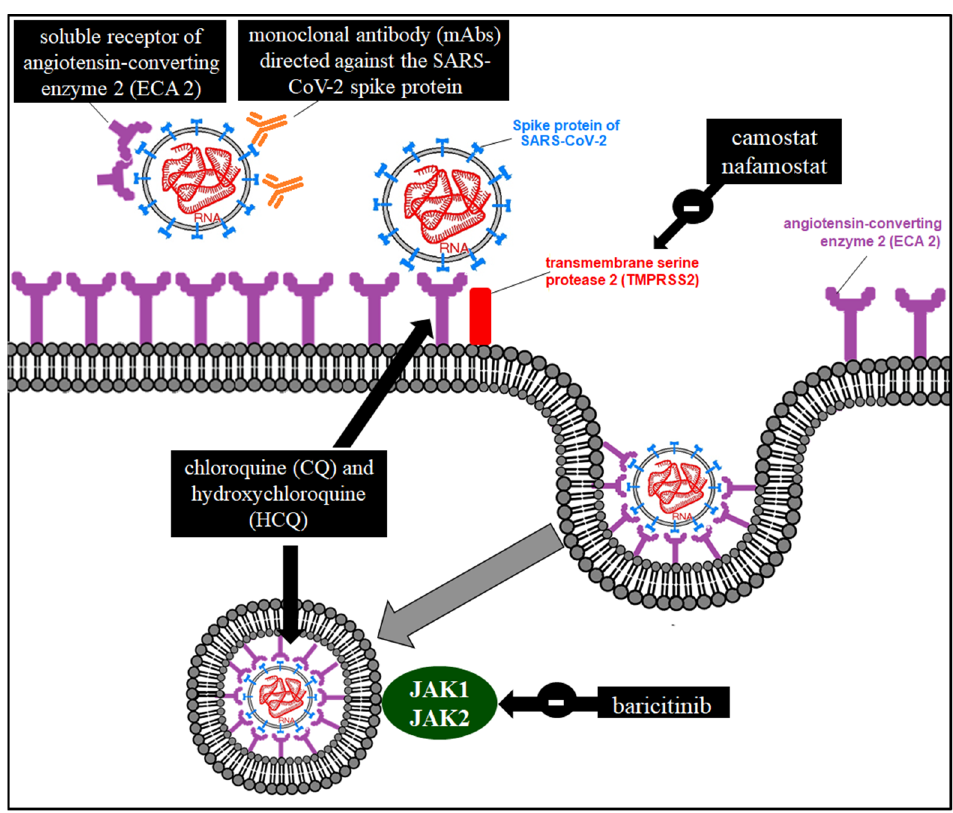
Figure 4. Possible pharmacological mechanisms of action in the interference of SARS-CoV-2